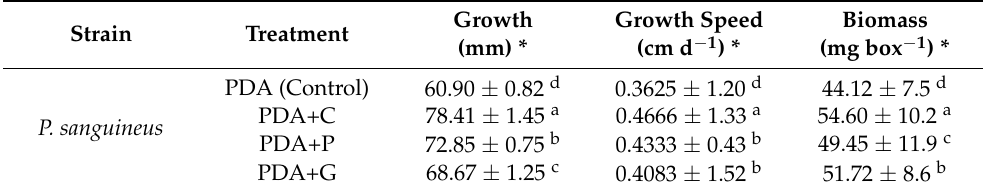
Table 1. Radial growth, specific growth rate and biomass obtained at 7 days of incubation for